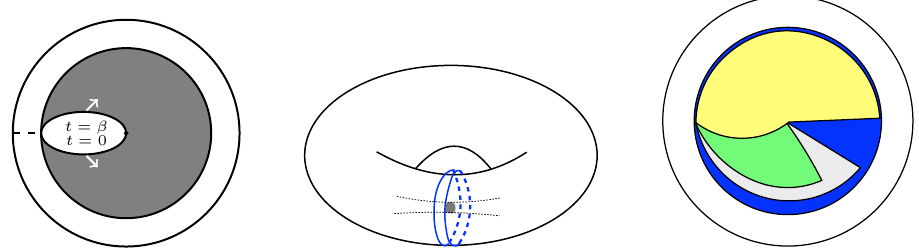
Figure 11 . (Color online) Left: the side view of tr (cid:26) A for the \ring"; the dashed line is only used to separate t = 0 and t = (cid:12) ends of the grey region. Middle: the front view of tr (cid:26) A for the \ring" con(cid:12)guration. Right: the side view of tr (cid:26) 4 inside the \ring" of the (cid:12)rst tr (cid:26) A A